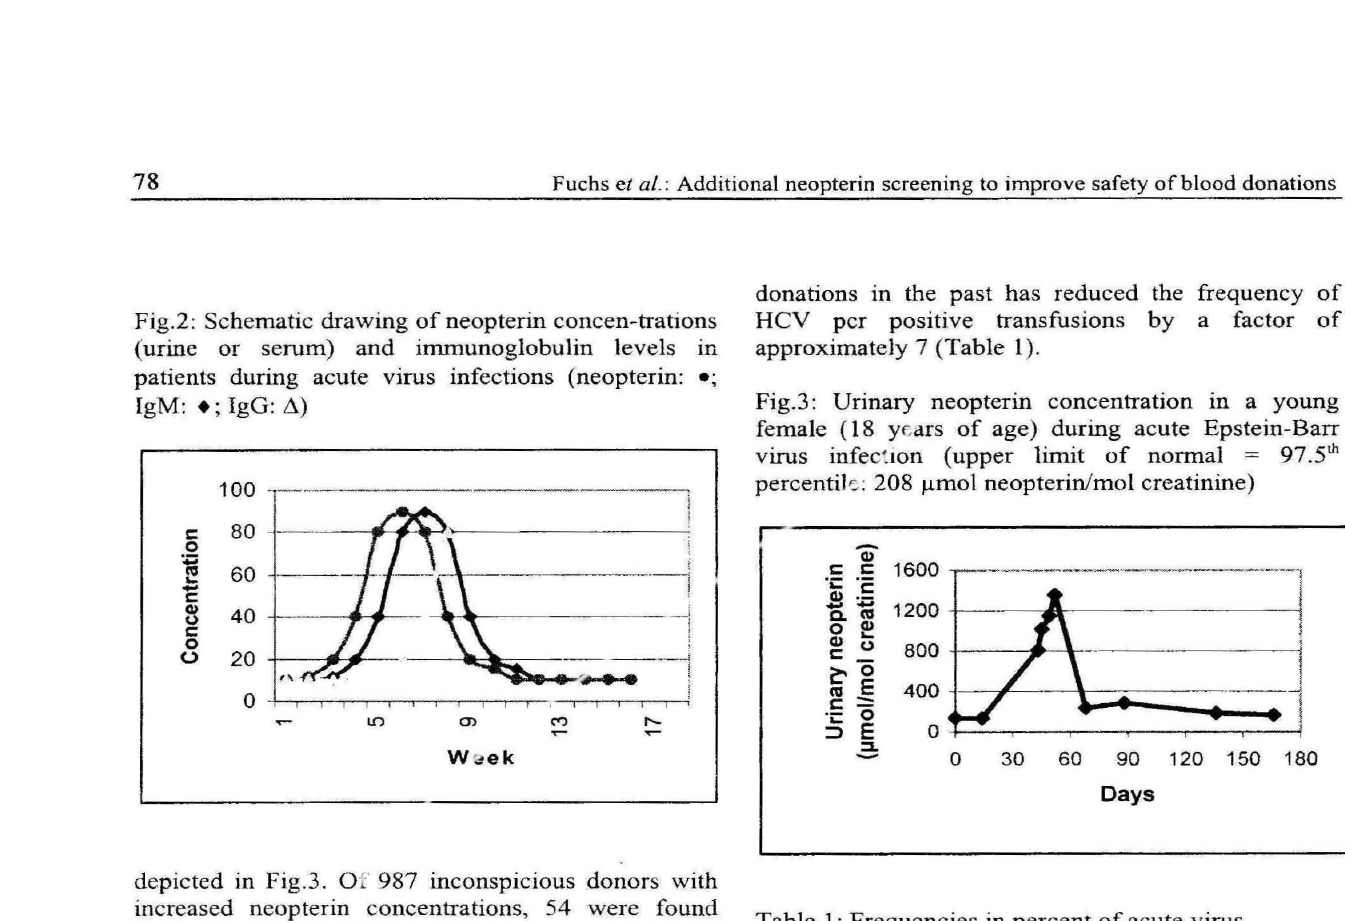
Table 1: Frequencies in percent of acute virus infections as detected by specific IgM screening and polymerase chain reaction (per) in blood donations with increased or normal neopterin concentrations I Neopterin concentration elevated normal (>10nmoIlL) (:510 CMV IgM seropositive EBV IgM seropositive in HeV antibody seropositive donations